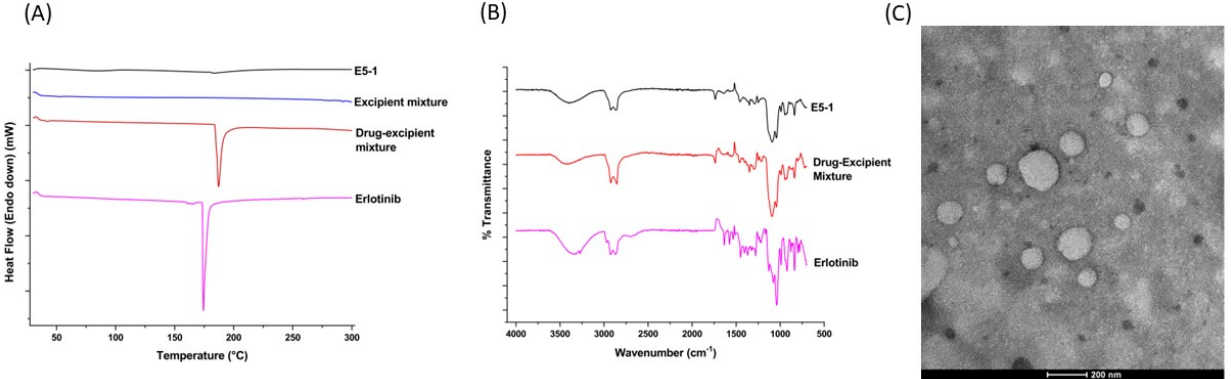
Figure 2. Physicochemical characterization of the nanoemulsion: diffraction scanning calorimeter thermograms ( A ) and Fourier transform infrared ( B ) of the erlotinib-free solution, drug–excipients mixture, excipients mixture (only DSC), and nanoemulsion E5-1. Transmission electron microscope (TEM) images of E5-1 nanoemulsion ( C ), with a scale bar of 200 nm.